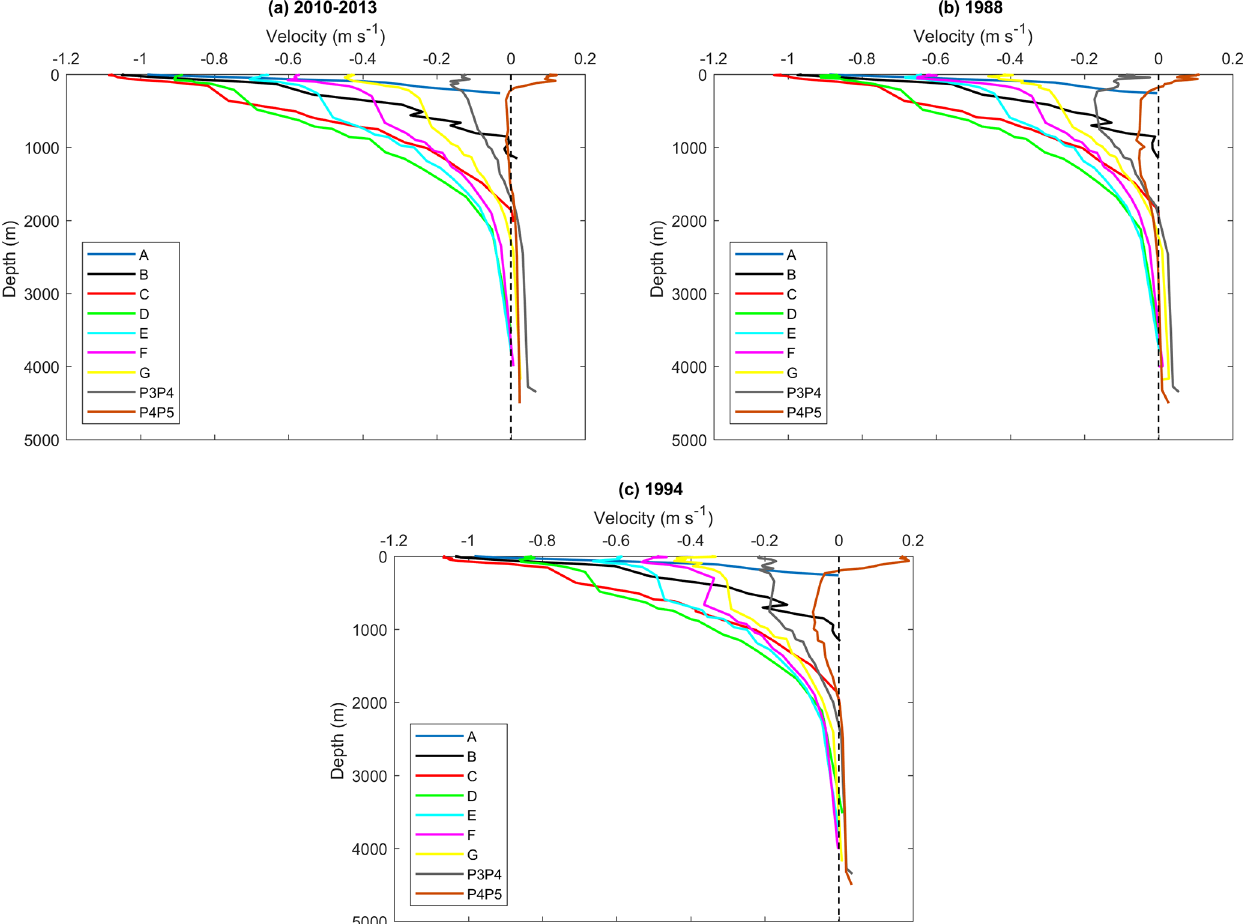
Figure 7. Mean cross-track velocity profiles (ms − 1 ) during (a) the 3-year reference period (2010–2013), (b) during the highest correlated year (1988), and (c) the lowest correlated year (1994). Each colour represents the different moorings (A–G) and CPIES pairs (P3P4 and P4P5). Negative values indicate southwestward